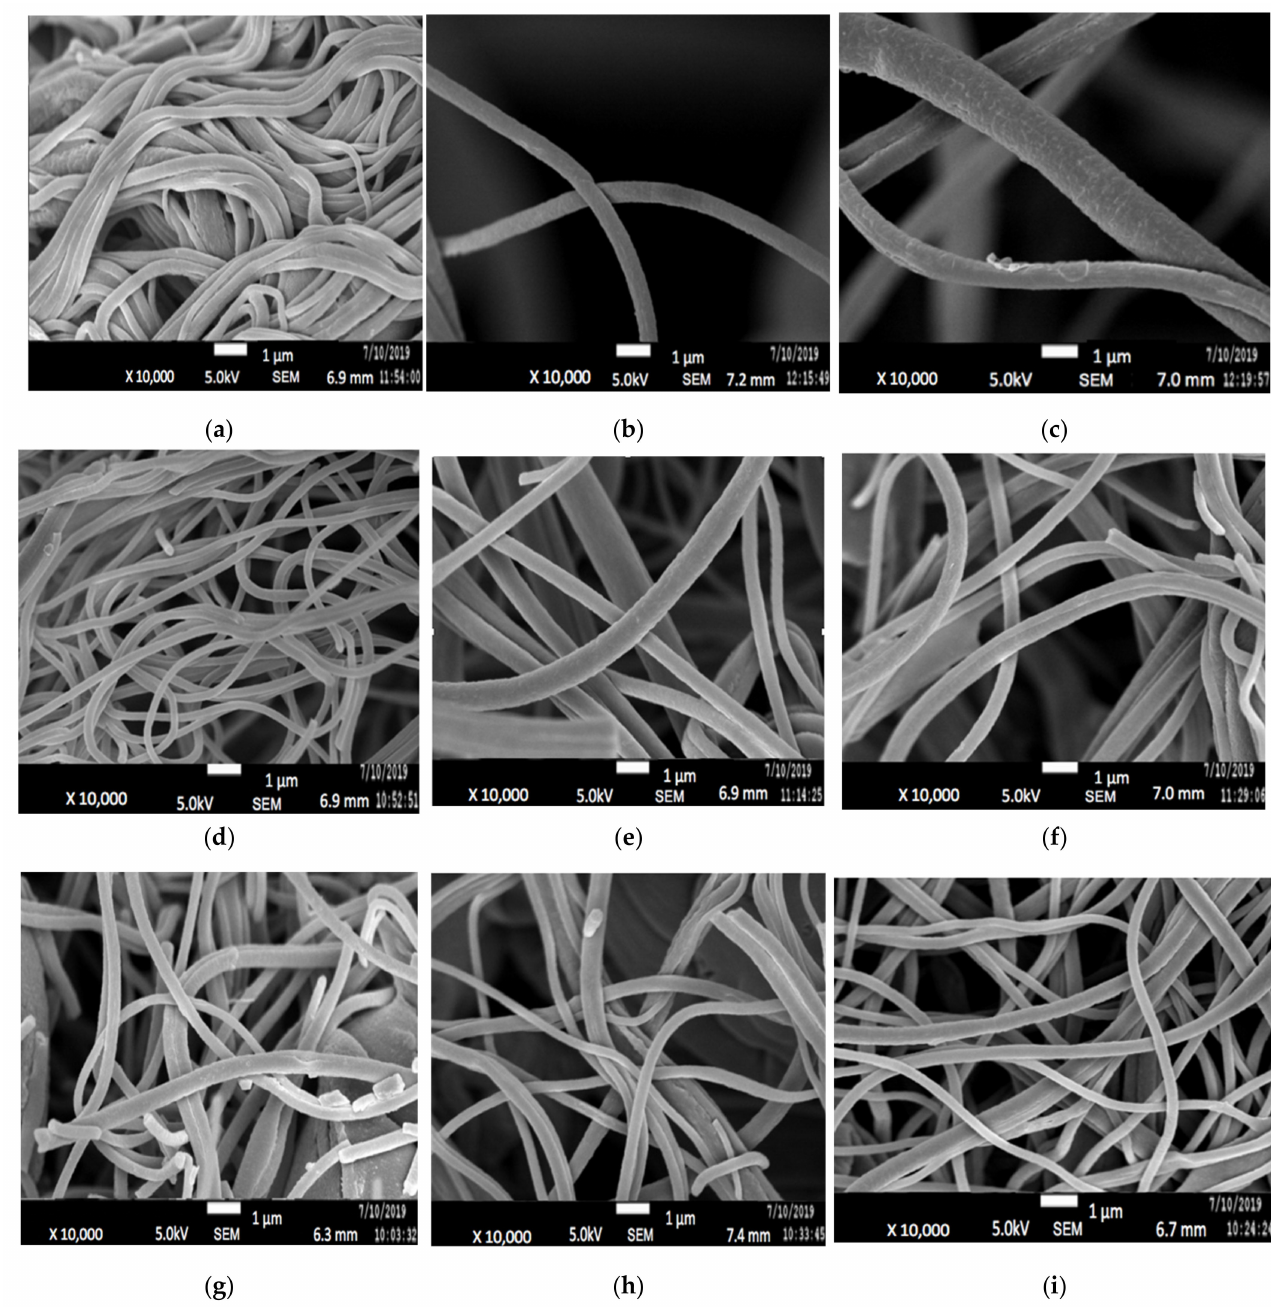
Figure 1. FESEM images of ( a ) 9:1 PAN/Lignin 10 wt% PEG; ( b ) 9:1 PAN/Lignin 15 wt% PEG; ( c ) 9:1 PAN/Lignin 20 wt% PEG; ( d ) 8:2 PAN/Lignin 10 wt% PEG; ( e ) 8:2 PAN/Lignin 15 wt% PEG; ( f ) 8:2 PAN/Lignin 20 wt% PEG; ( g ) 7:3 PAN/Lignin 10 wt% PEG); ( h ) 7:3 PAN/Lignin 15 wt% PEG; ( i ) 7:3 PAN/Lignin 20 wt% PEG at 10,000 ×